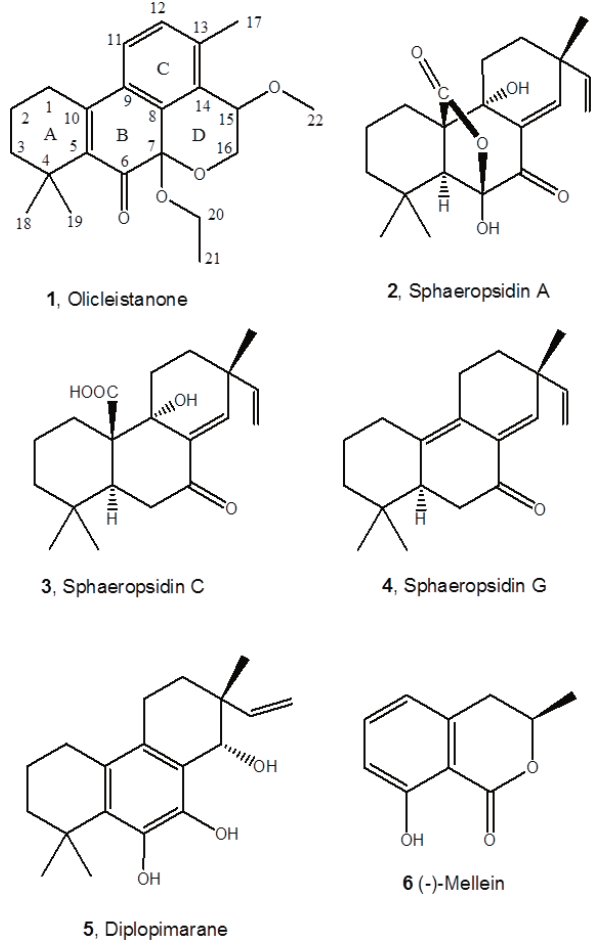
Figure 2. Structures of olicleistanone ( 1 ), sphaeropsidins A, C and G ( 2 , 3 and 4 ), diplopimarane ( 5 ) and (-)-mellein ( 6